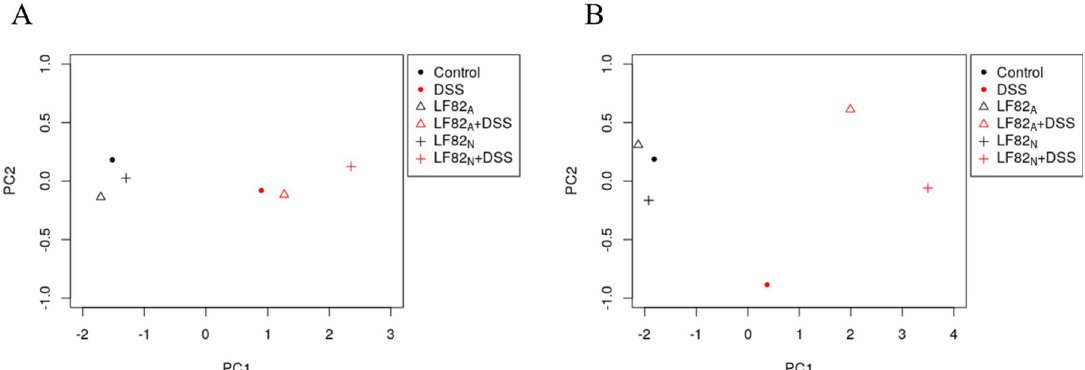
Fig 6. PCA plots. PCA plot depicting the clustering of samples originating from control ASF mice and ASF mice colonized with E . coli LF82 in the presence or absence of DSS exposure. A) PCA plot generated by incorporating data based on measurements of colon length, macroscopic lesions, and histological evaluation and B) PCA plot generated by incorporating data based on measurements of colon length, macroscopic, and histologic scores plus tissue cytokine